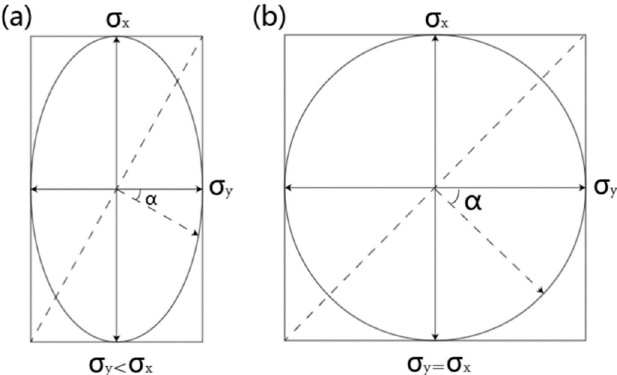
Figure 8. Stress ellipse of biaxially stretched PI membrane when the principal stress in the Y-direction is smaller than that in the X-direction ( a ) and when they are equal to each other ( b ).